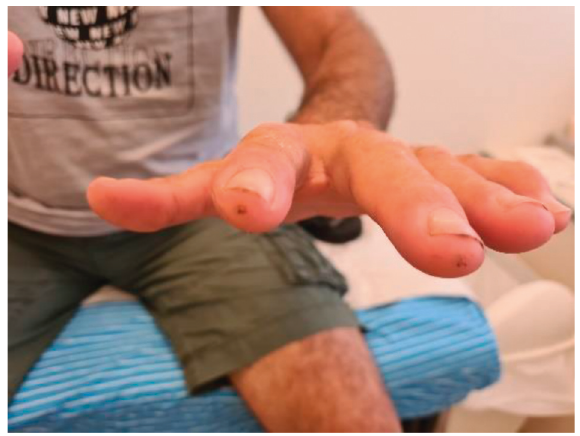
Figure 1: Pitting scars at the tip of the digits.